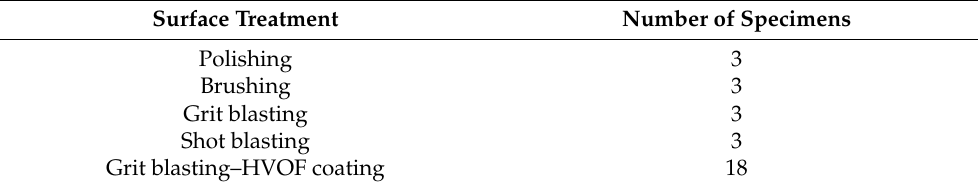
Table 1. Summary of slip factor test specimens.